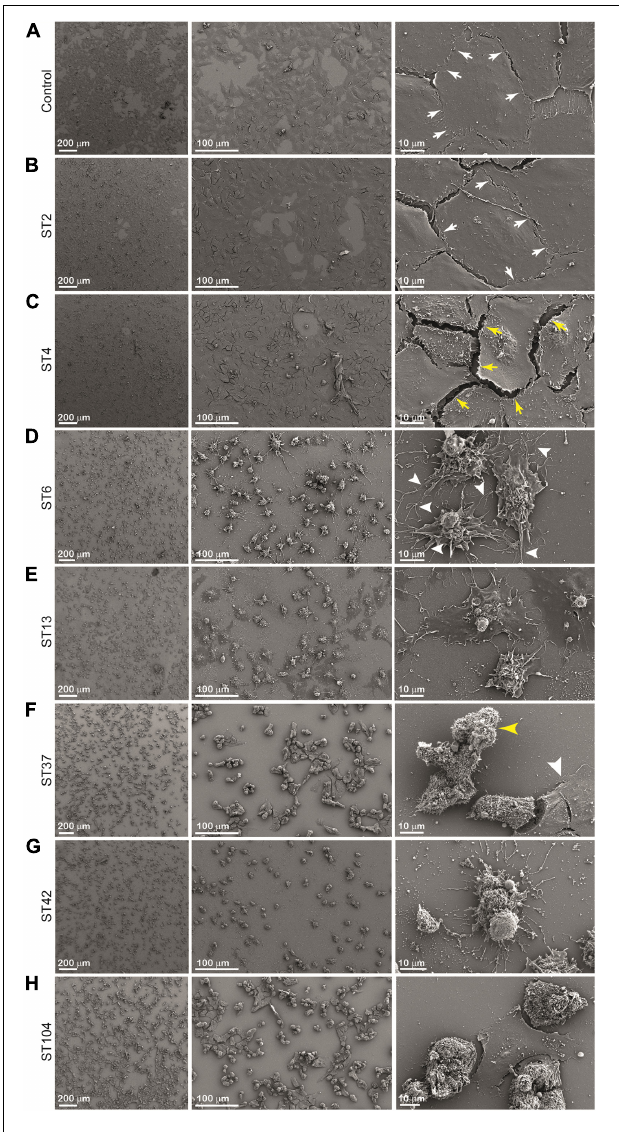
FIGURE 5 | Cytopathic effect (CPE) of different sequence type (ST) strains on Vero cells [scanning electron microscopy (SEM)]. Cells were incubated with stool filtrates at 37 ◦ C, for 24 h. Following incubation, cells were visualized by scanning electron microscope. Representative images of (A) Vero cells only, and Vero cells treated with (B–H) ST2, ST4, ST6, ST13, ST37, ST42, and ST104-positive stool supernatants, respectively. Scale bar: 200, 100, and 10 µ m. n =